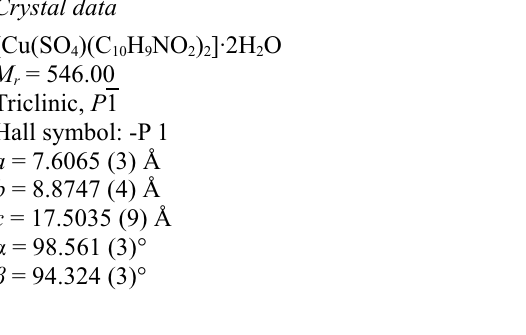
Packing of the title compound, viewed along the a axis. The hydrogen bonds are depicted as dashed lines. Bis[(2-quinolyl)methanediol- κ 2 N , O ](sulfato- κ O )copper(II) dihydrate Crystal